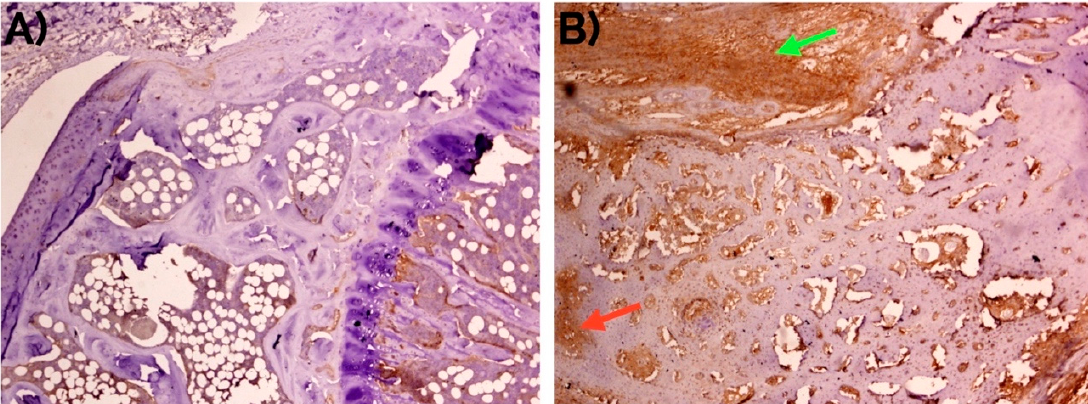
Figure 9. Weak to negative detection of periostin at day 14 in ( A ) unfractured controls in comparison with ( B ) bone fracture callus, where it can be observed mainly in the fibrocartilage (green arrow) and in the intertrabecular interstitium (red arrow). Peroxidase-conjugated micropolymer detection. Original magnification: 10×.